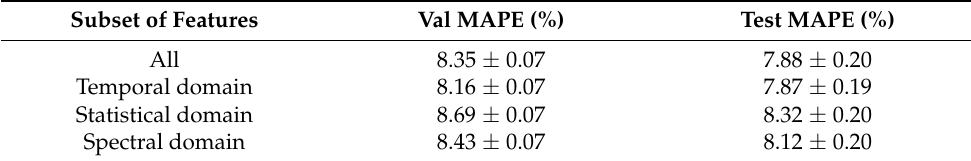
Table 6. Results of regression task using different subsets of features from 2-s sub-windows. Subset of Features